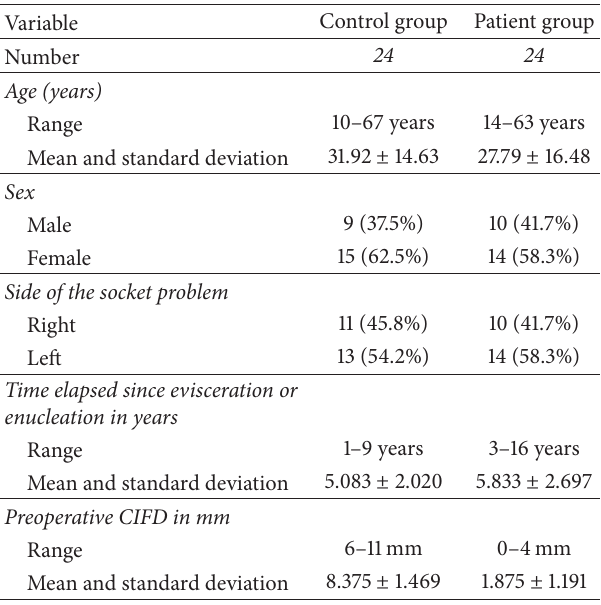
Table 1: Depicting demographic data and preoperative CIFD of control and patient groups.